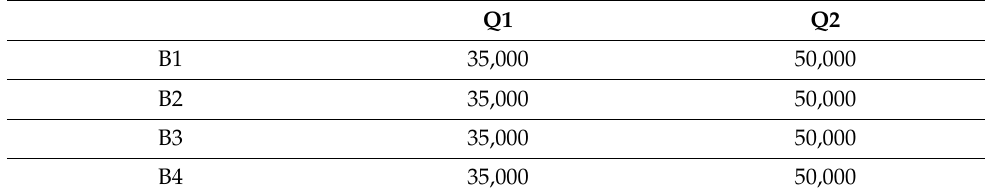
Table A2. Pelletization capacity of the plant (tons/period).